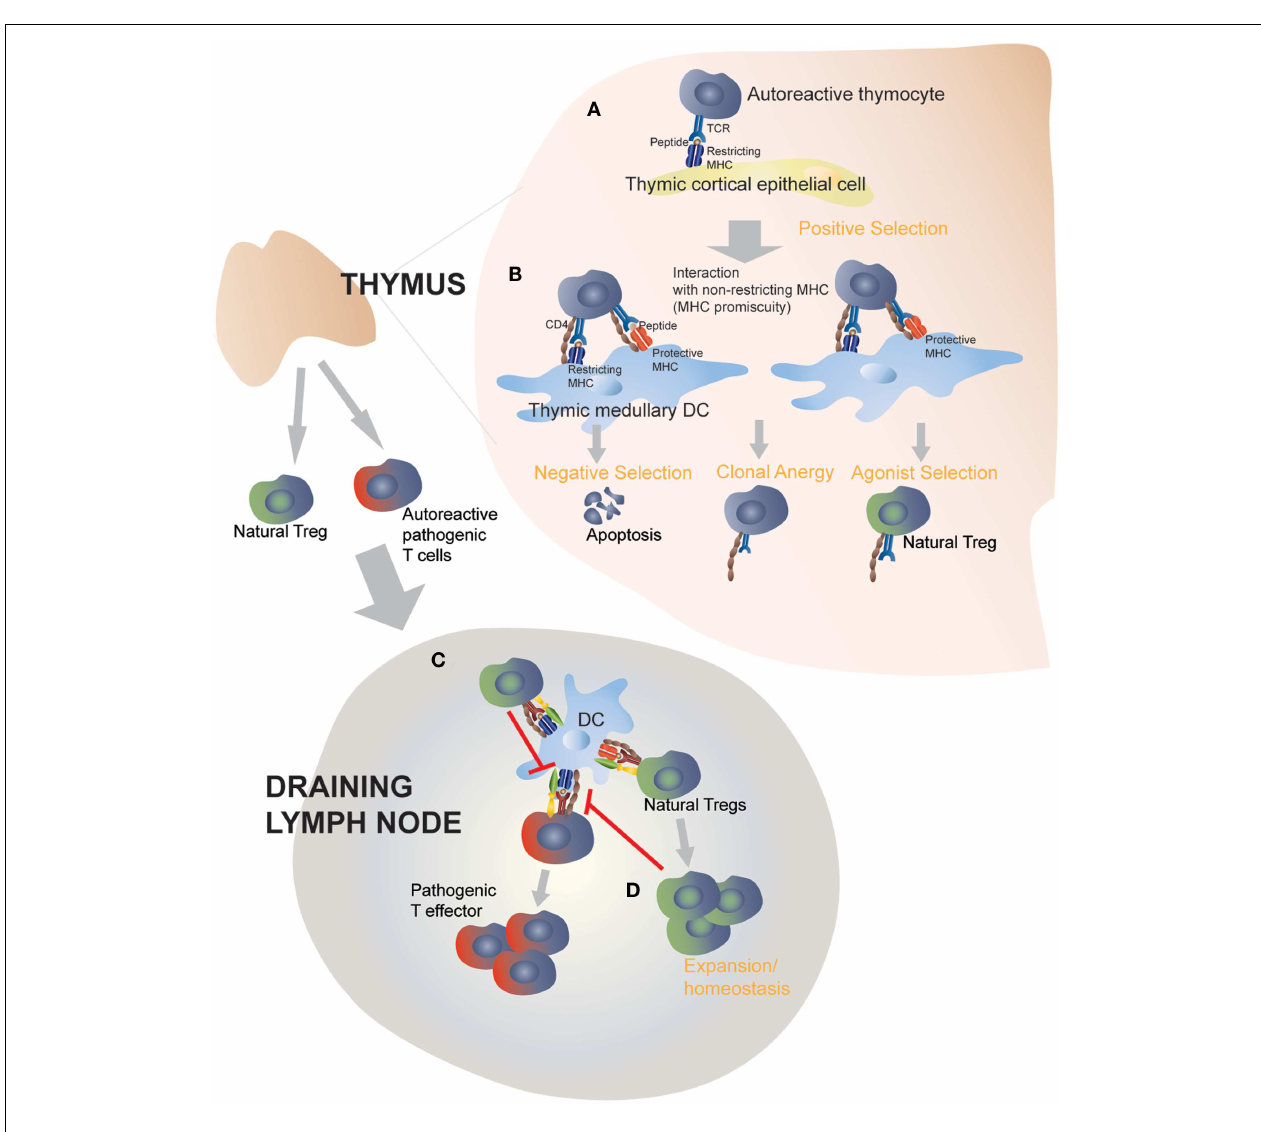
autoreactive, MHC-promiscuous thymocytes, and promotes autoreactiveTreg differentiation and functional development ( C ).Thymic derivedTregs then exit into the periphery and suppress the activation of pathogenicT cells by directly acting on autoantigen-loaded APCs.This step does not require protective MHC class II molecules, although a role of protective MHC class II molecules, expressed on peripheral APCs, in perpetuating autoreactiveTregs or enhancing their homeostasis cannot be ruled out (D)